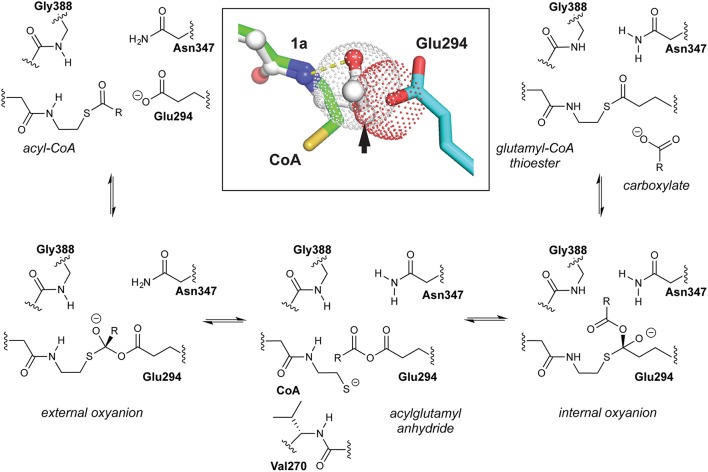
Class I CoA-transferase mediated acyl transfers involve two spatially distinct oxyanion holes. The reversible conversion of acyl-CoA substrate to the carboxylate product is shown, a half-reaction that converts free enzyme into a glutamyl-CoA thioester adduct. The other half-reaction reverses this reaction sequence. Inset, overlay of the “open” AarC•CoA complex (PDB entry 4eu7) with the “closed” AarC-E294A•1a complex (PDB entry 4euc) indicates that constriction of the active site around an acyl-CoA substrate causes extreme C/O overlap at an approach angle close to the ideal for nucleophilic attack on an unsaturated carbon (the Bürgi-Dunitz angle, 107°). The arrow indicates the position of the sulfur-for-methylene substitution in the AcCoA analog 1a, which contains a nonhydrolyzable ketone.